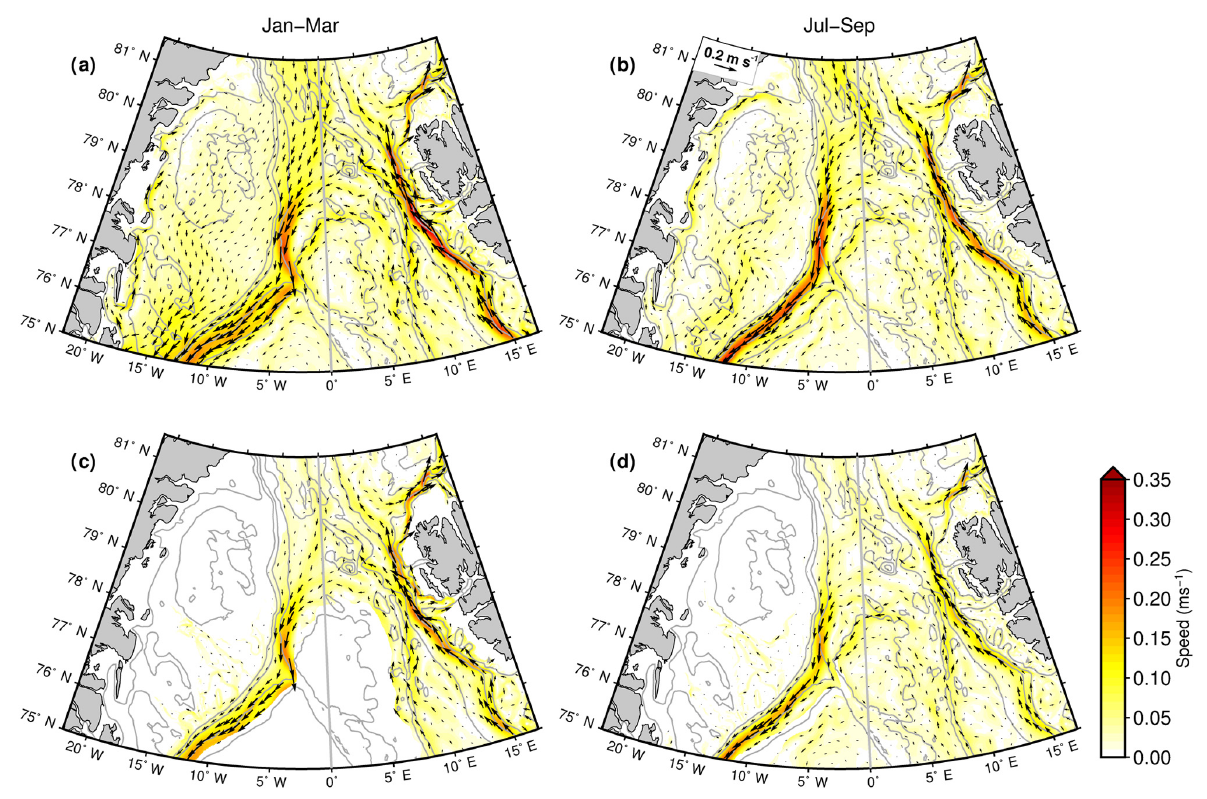
Figure 8. (a, b) simulated velocity at 75m depth and (c, d) depth-averaged simulated velocity in the AW layer (water warmer than 2 ◦ C) for the time periods (a, c) January–March and (b, d) July–September from FESOM. Thin grey lines are bathymetry, black arrows show current speed and direction, and the coloured shading shows the